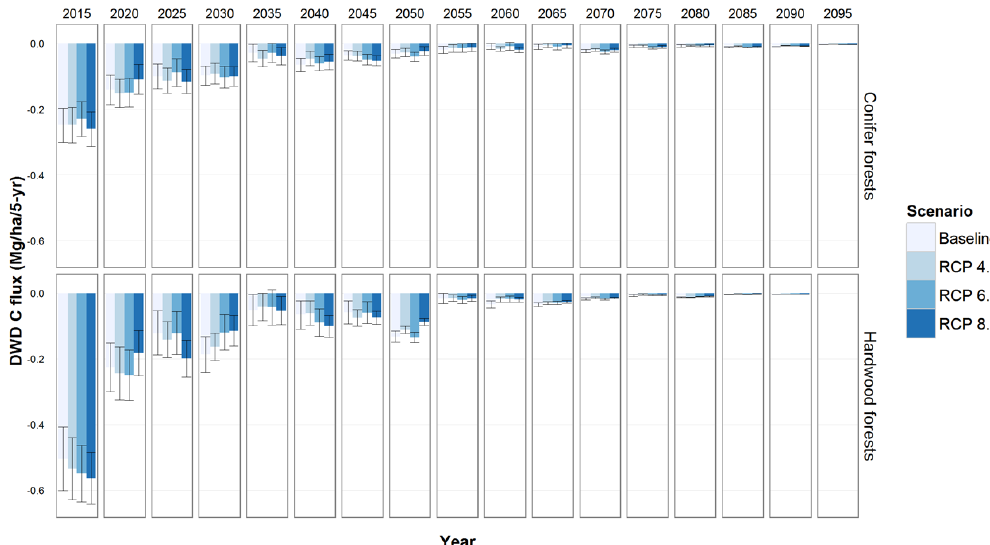
Figure 3. Projected downed woody debris carbon flux initialized using the most recent inventory (2007–2011) in eastern US forests for a baseline current-climate scenario and assuming changes in future climate (based on three RCP scenarios from an ensemble of 17 CMIP5 models and not accounting for future DWD inputs). Error bars indicate ± one standard error. Conifer forests include loblolly–shortleaf pine, longleaf–slash pine, spruce–fir, white–red–jack pine, and other softwood forest type groups. Hardwood forests include aspen–birch, elm/ash/cottonwood, maple/beech/birch, oak/hickory, and other hardwood forest type groups. Table 3. Distribution of estimated decreases in downed woody debris residence time (years) by piece size, species group, and region for eastern US forests for a baseline current-climate scenario and assuming changes in future climate for up to 200 years (based on an RCP 6.0 scenario from an ensemble of 17 CMIP5 models). Species group Region Length Quantile (years) Min 25 50 Max Conifers North